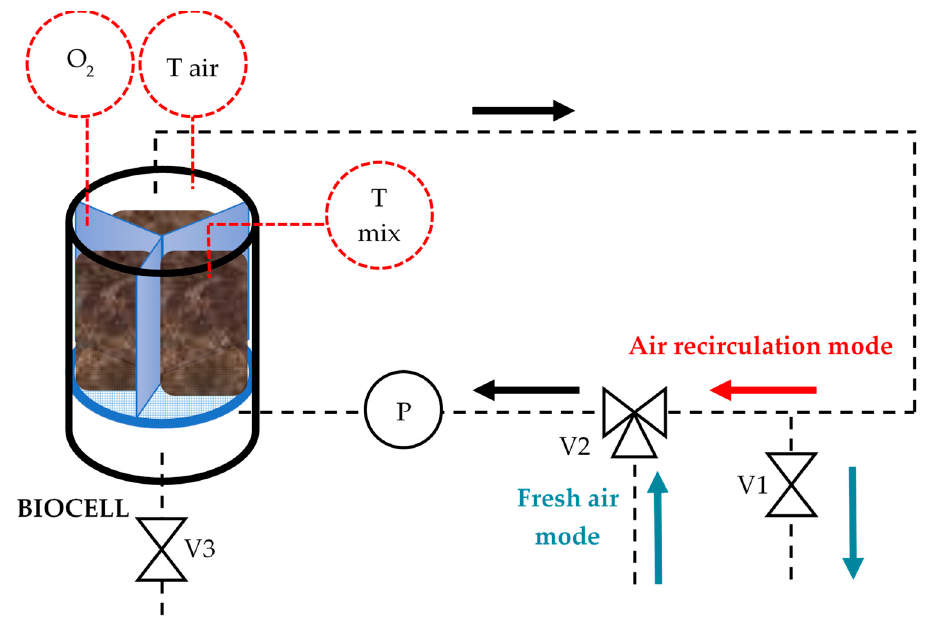
Figure 1. Scheme of the bioreactor configuration.